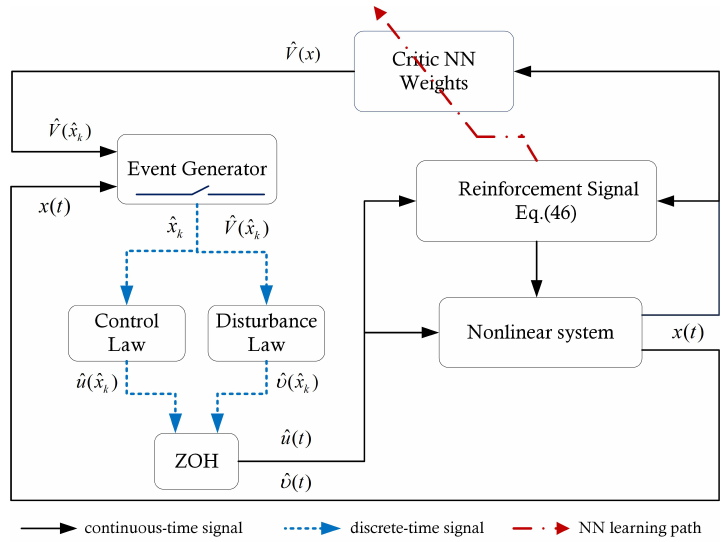
Figure 1. The structure diagram of Event-triggered ADP